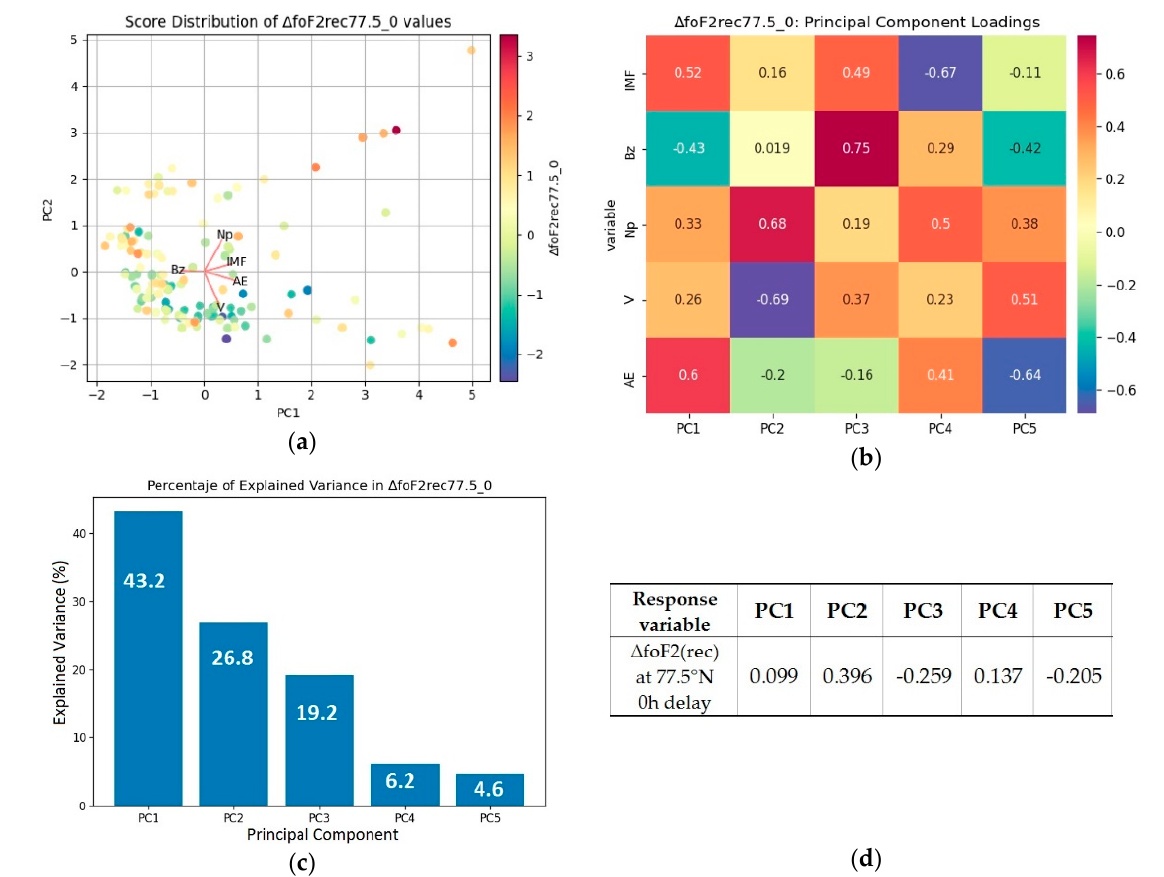
Figure 15. The results of Principal Components Analysis (PCA) for ∆ foF2 time series at 77.5° N during 7–17 March 2012: ( a ) distribution of ∆ foF2 values (vectors in the planes of five original explanatory variables) as a function of principal components PC1 and PC2; ( b ) covariance matrix; ( c ) scree plot of PC impacts; ( d ) multiple regression coefficients of the response variable in terms of PCs.